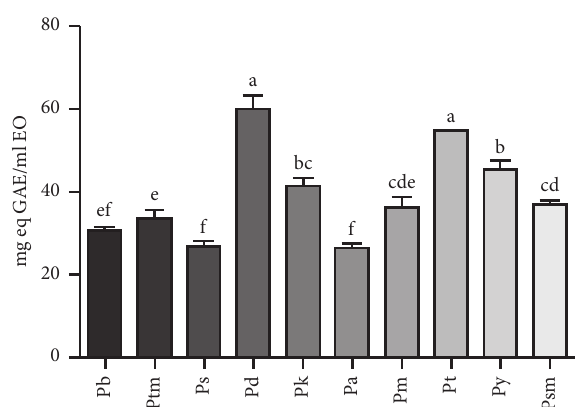
Figure 1: Total phenolic content of the studied essential oils. Different letters show significant differences at the 0.05